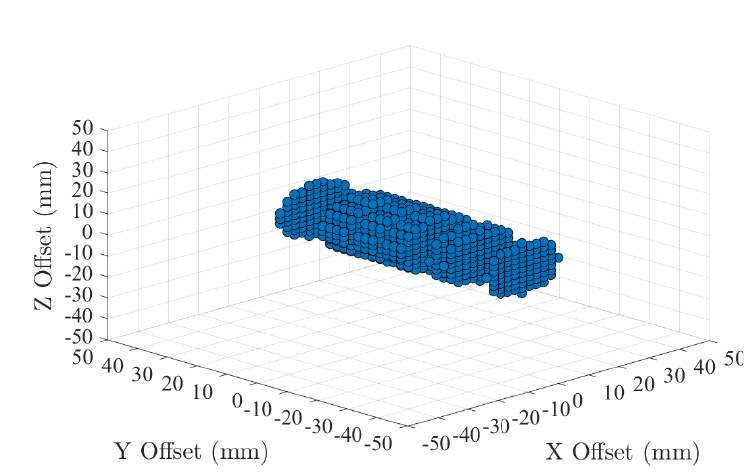
Figure 9. Simulated quiet zone for 20dBi antenna at 115GHz.